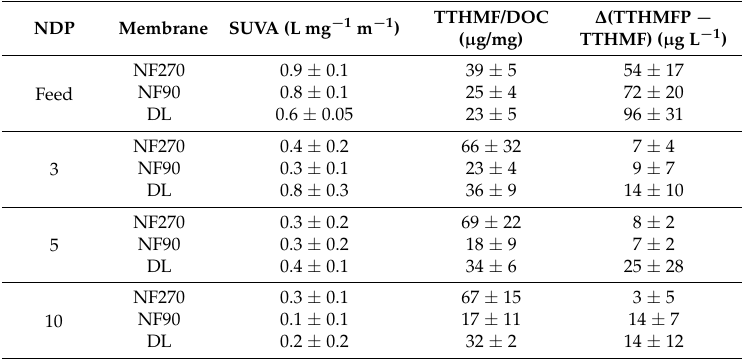
Table 2. Average values of specific UV 254 absorbance (SUVA), TTHMF/DOC, and ∆ (TTHMFP − TTHMF) measurements for NF270, NF90, and DL as a function of feed